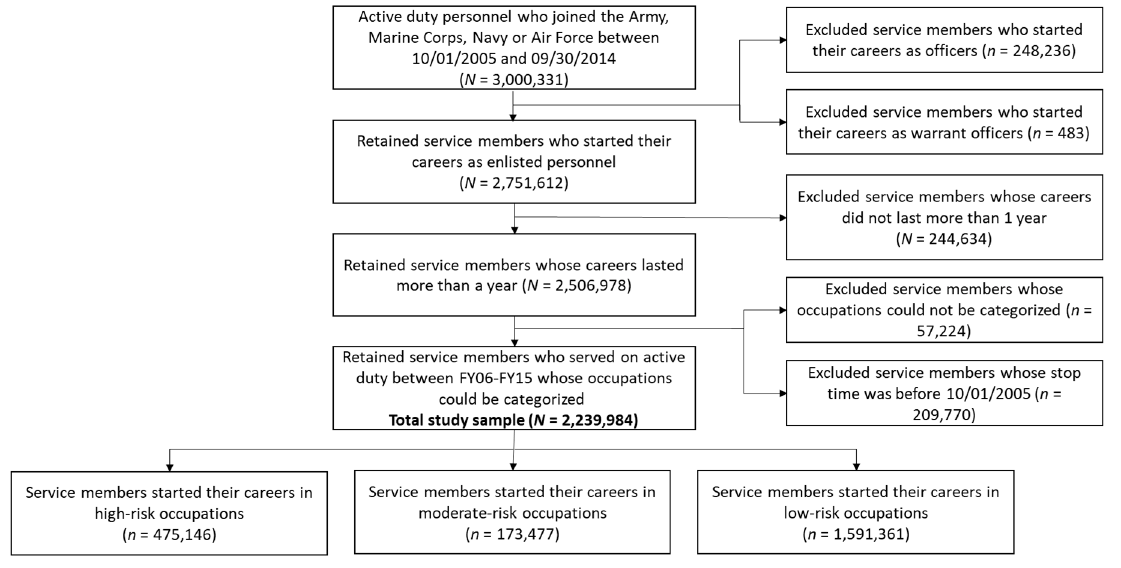
Figure 1. Flow diagram.